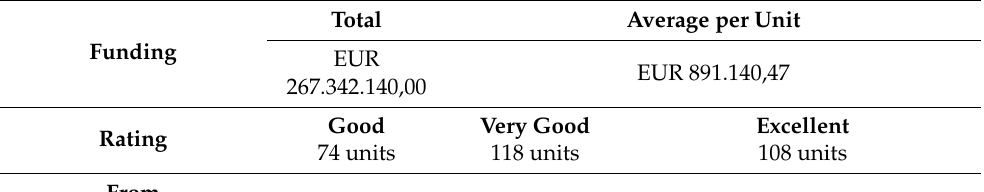
Table 4. Absolute values for each category of the